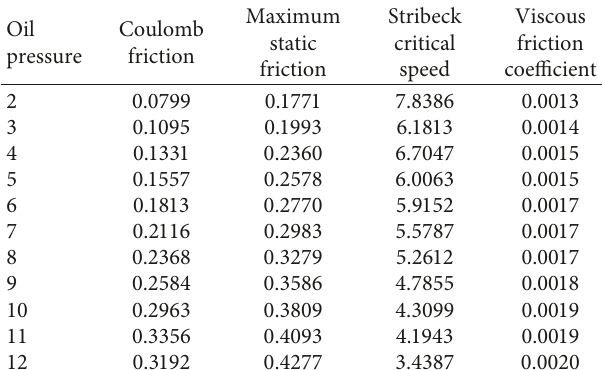
Table 1: Parameters of the Leuven friction model.